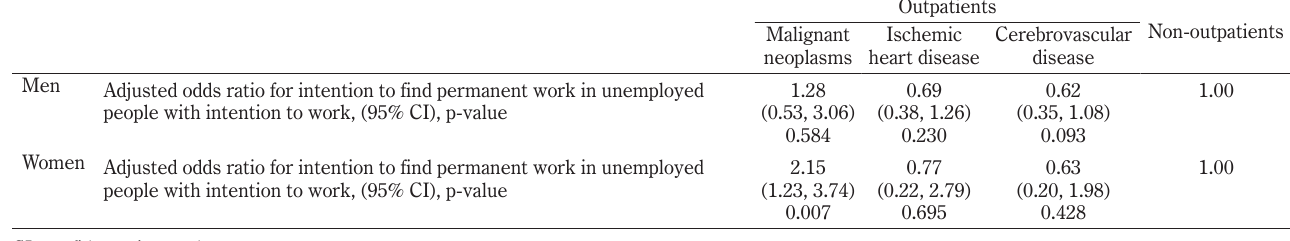
Table 5 Adjusted odds ratios for intention to find permanent work in unemployed people with the intention to work among outpatients with malignant neoplasms, ischemic heart disease, and cerebrovascular disease, compared with